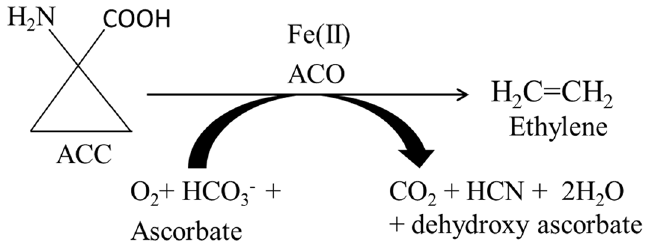
Figure 1. Schematic representation of ethylene biosynthesis by the activity of 1-aminocyclopropane-1- carboxylate oxidase